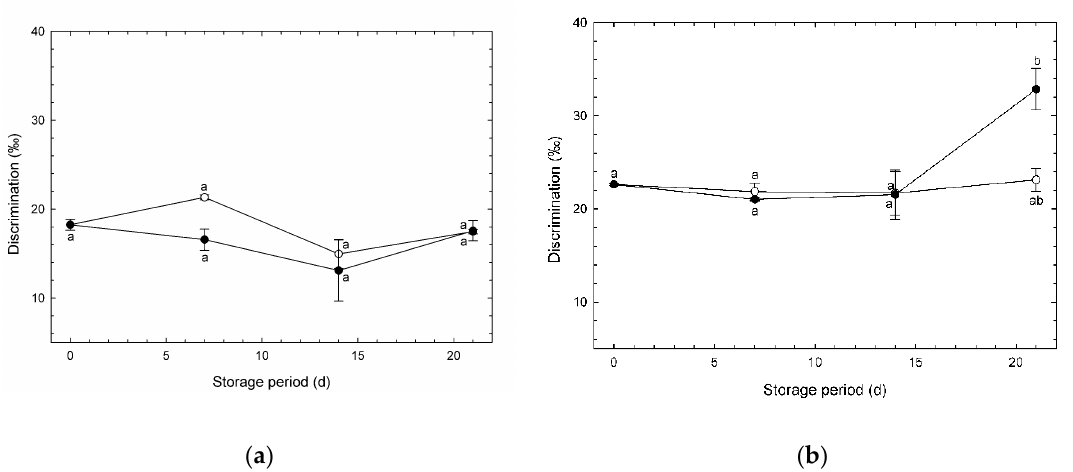
Figure 7. Discrimination factor ( D ) (O 2 isotope discrimination factor for alternative oxidase / cytochrome c oxidase activity ratio) in broccoli heads during storage at 1 ◦ C. ( a ) Experiment #1: O 2 / CO 2 = 2.5% / 6.0% ( + N 2 to 100%). ( b ) Experiment #2: to 100%). Values are means ± SE of three biological replicates. Significant di ff erences ( p < 0.05) are denoted by di ff erent